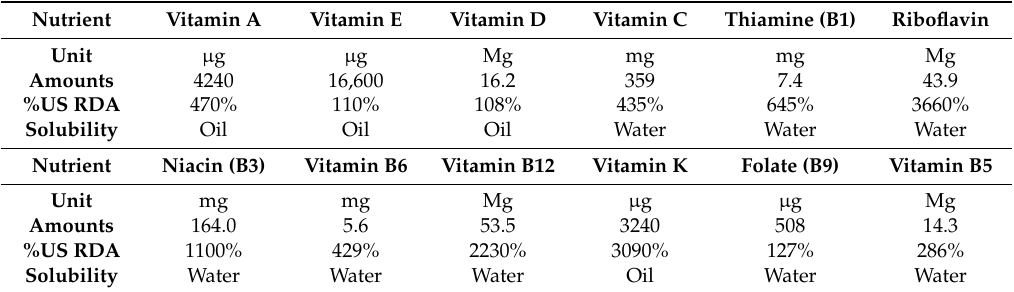
Table 2. Sample diet of alternative foods and US RDA micronutrients. Solubility data provided by [51].